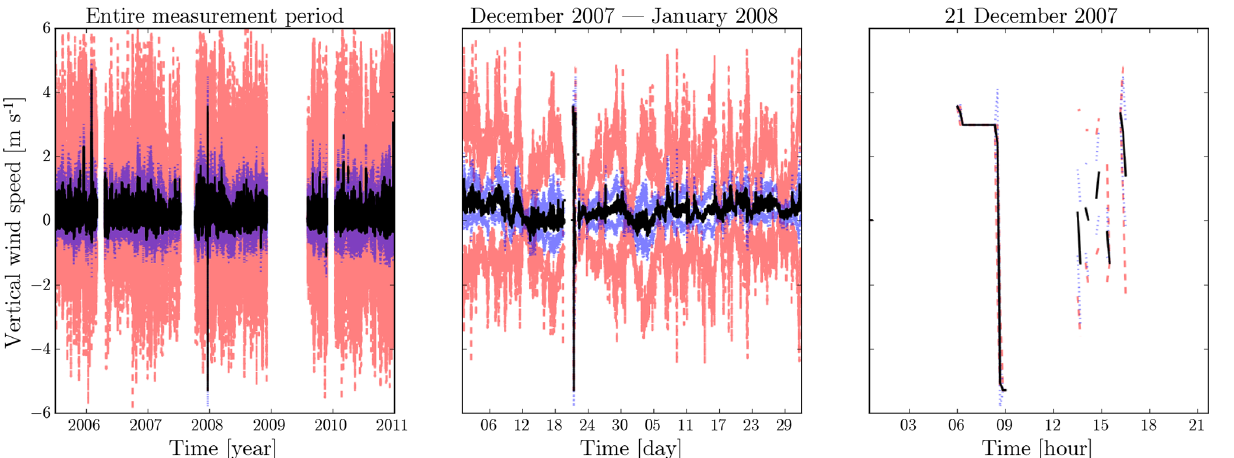
Figure 2. An illustration of the visual inspection and zooming of plots. We present the OWEZ vertical wind speed data collected by the ultrasonic anemometer at the NE-116m location. (Mean in black; mean ± standard deviation in blue; minimum and maximum in red.) Table 2. An overview of the (largest) range violations present in the FINO1 dataset. (Values rounded to three digits.) Instrument Quantity Unit Statistic Lowest Instr. range Highest Cup anemometer hor. wind sp. ms − 1 Minimum 0.0313 0.1–75 Maximum 0.1–75 1690 Ultrasonic anemometer hor. wind sp. ms − 1 Maximum 0–45 45.6 wind direction ◦ Average 0–359 360 Wind vane wind direction ◦ Maximum 0–360 521 Average 0–360 366 Barometer atm. pressure hPa Average 0.00391 800–1060 Hygrometer rel. humidity % Average 0.0313 10–100 102 Precipitation sensor precip. intensity mA Average 0.00195 4–20 45.3 Pyranometer global radiation Wm − 2 Average − 4.86 0–4000